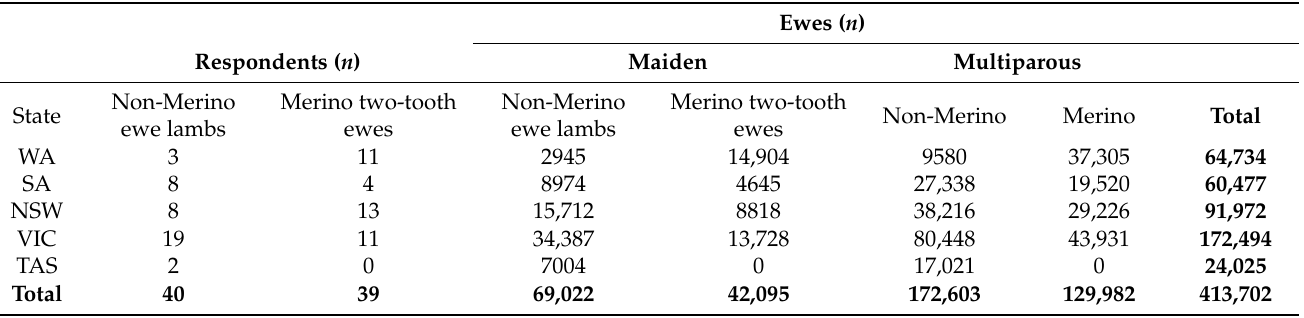
Table 1. Distribution of eligible survey responses by state based on number of respondents (farms) and total number of maiden and multiparous